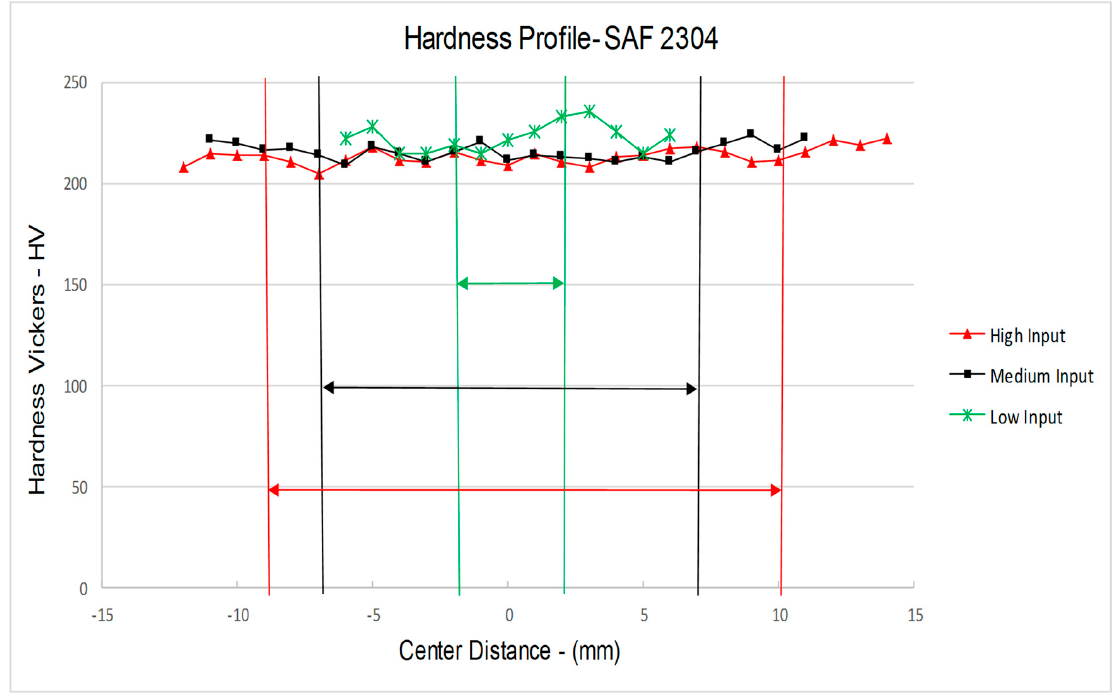
Figure 13. Vickers Hardness-SAF 2304. The arrows represent the distance from the weld center. i.e., width of WM. Values were measured from the base metal to the base metal, i.e., BM, LT-HAZ, HT-HAZ, WM, HT-HAZ, LT-HAZ, BM.